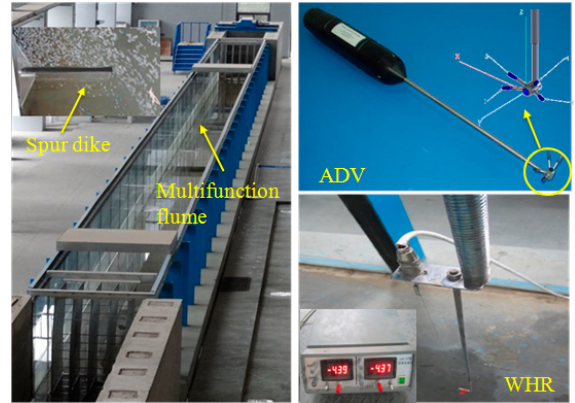
Figure 4. Multifunction flume facility and measuring instruments.